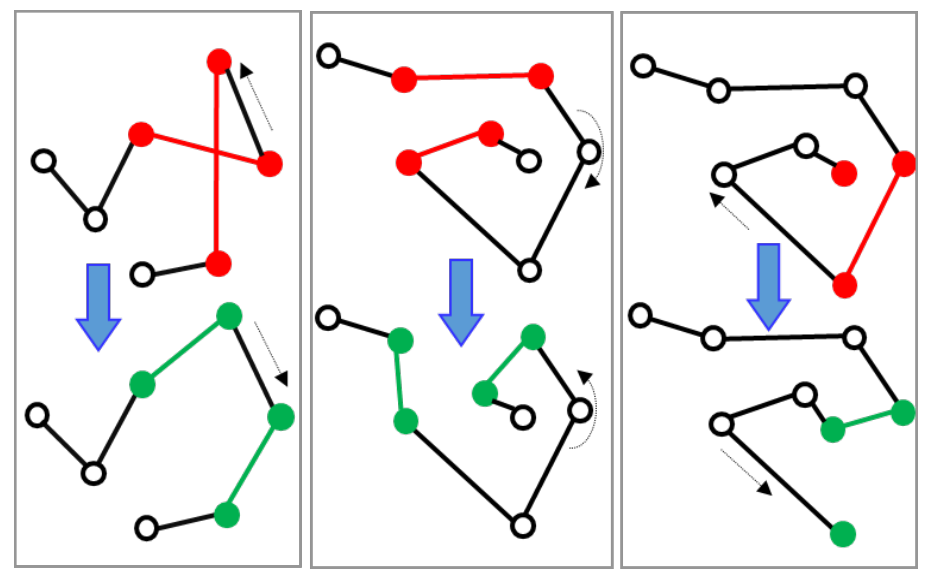
Figure 4. Three examples of how the 2-optimization method can improve the tour.